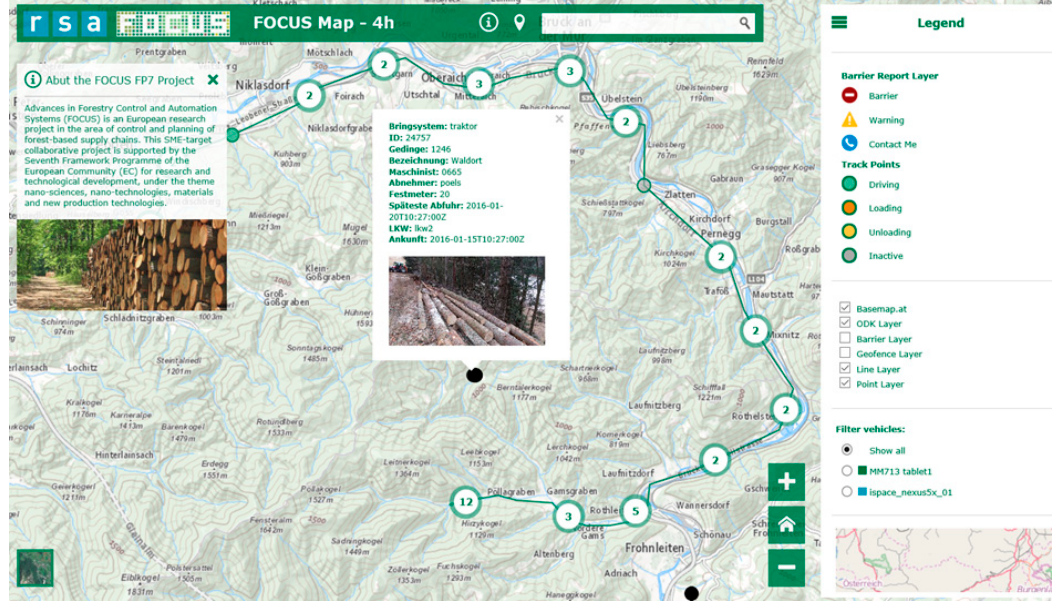
Figure 10. The “Monitoring app” showing the last 4 h (including tracks, truck states, barriers, environmental information).